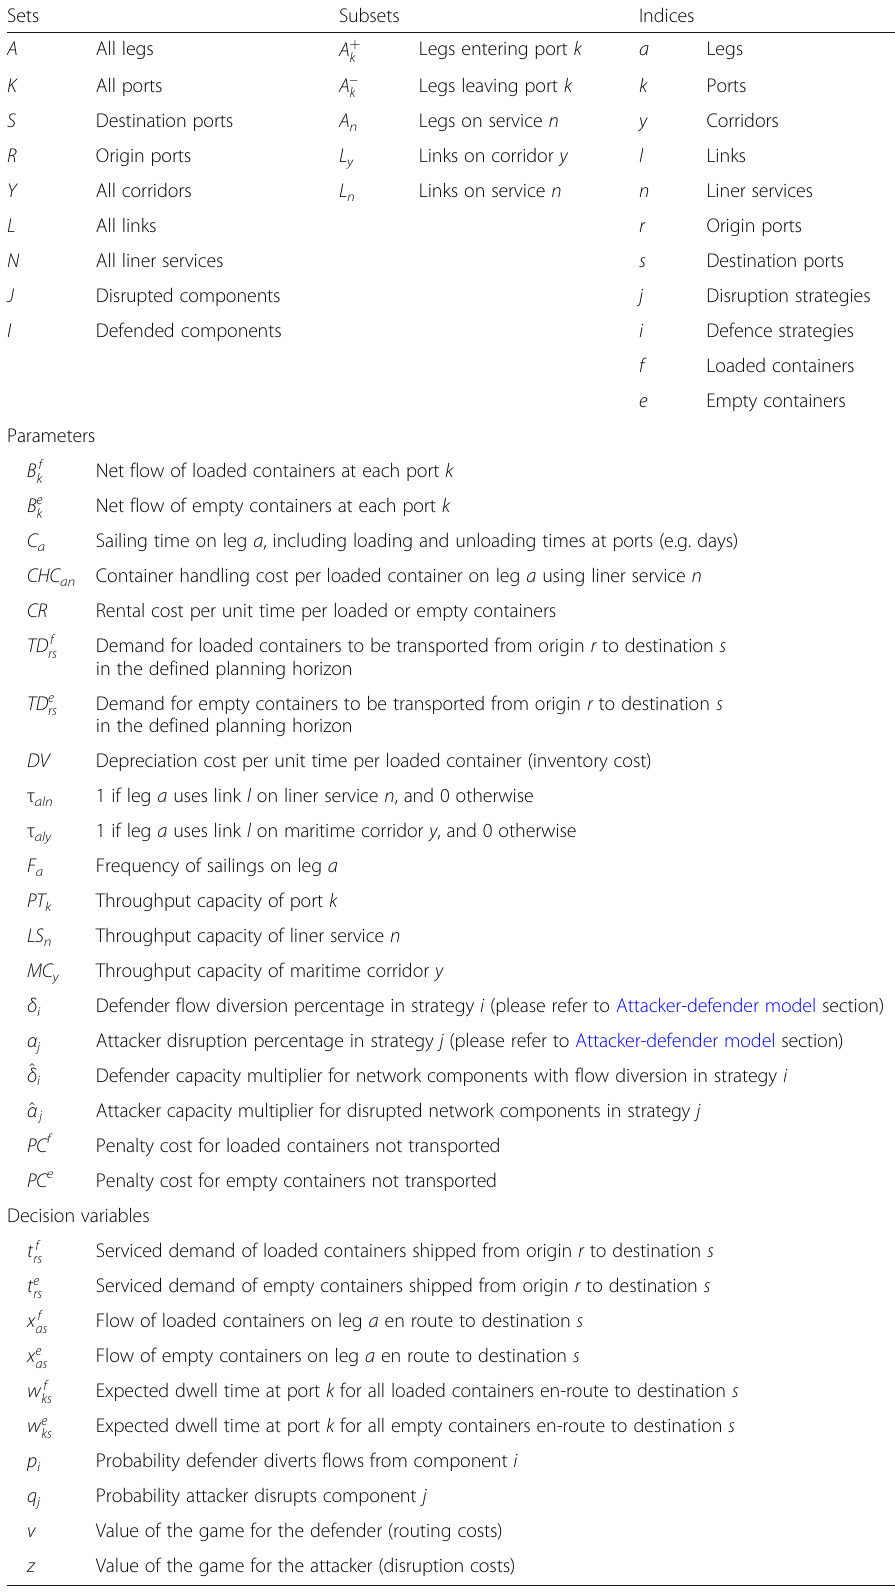
Table 1 CAM and ADM